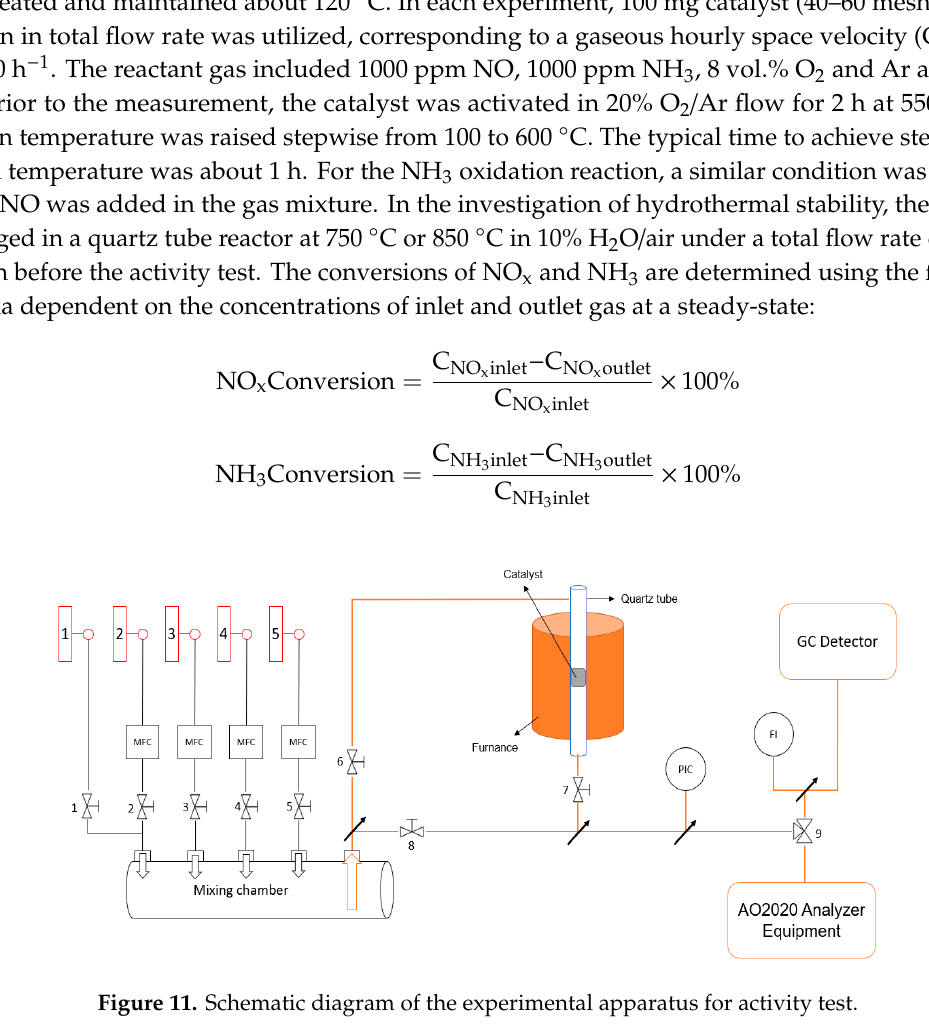
Figure 11. Schematic diagram of the experimental apparatus for activity test.